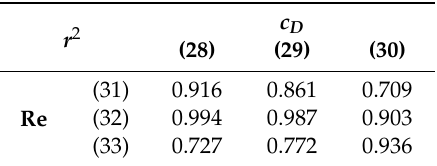
Table 3. Coe ffi cient of determination, r 2 , for di ff erent combinations of drag coe ffi cient, c D , and Reynolds number, Re, definitions.